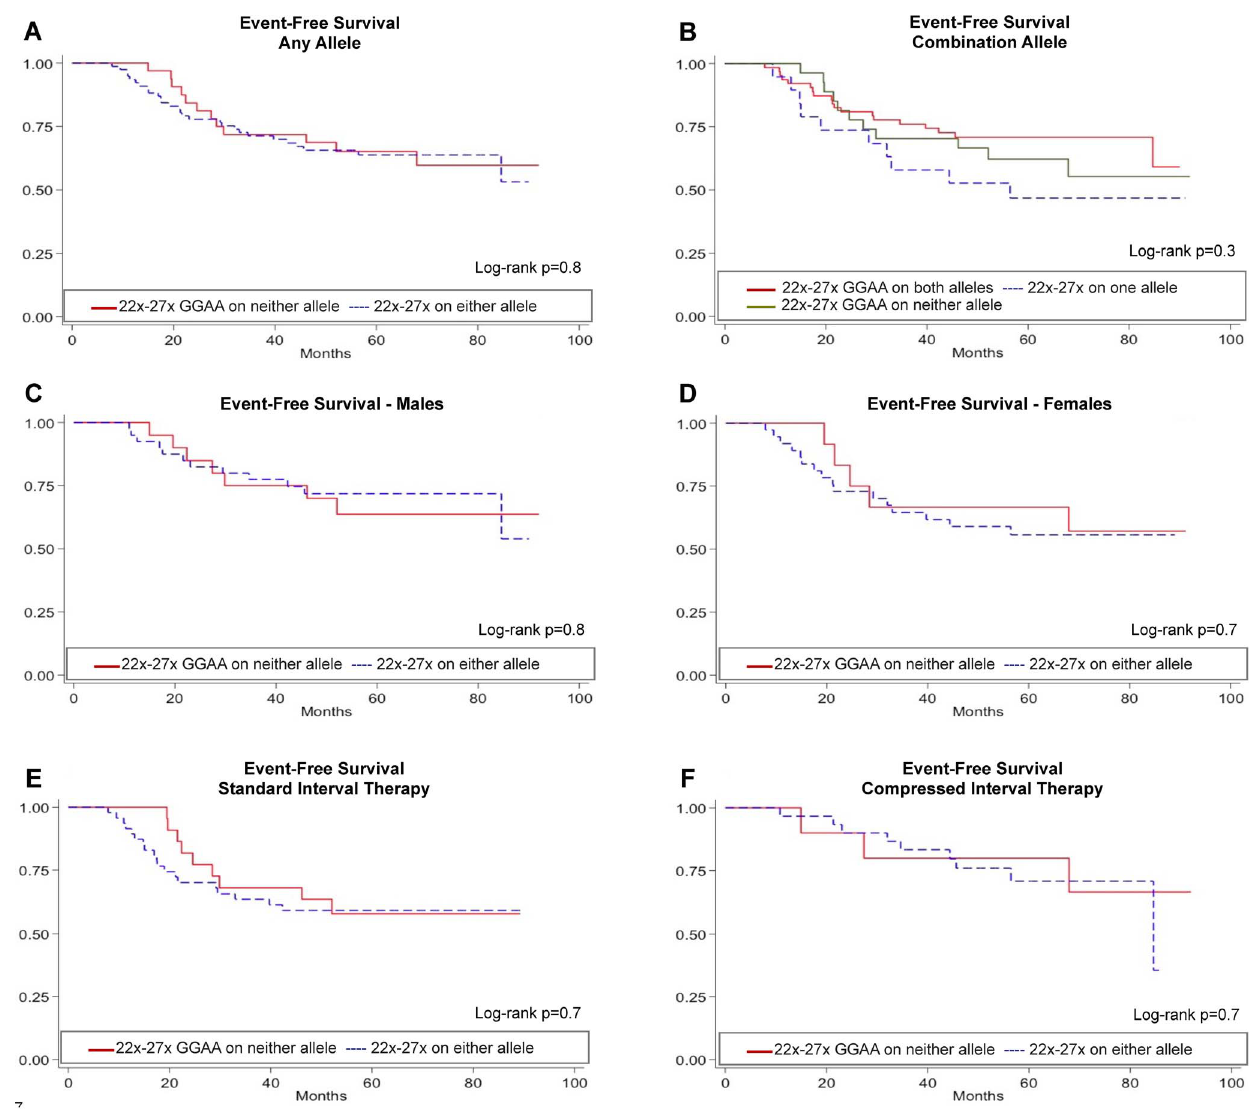
Figure 6. NR0B1 GGAA-microsatellite polymorphisms do not influence event free survival (EFS) in Ewing sarcoma patients. ( A ) EFS was compared in 112 patients from AEWS0031 based on the presence of absence of at least one NR0B1 GGAA-microsatellite allele containing 22–27 GGAA motifs. This allele type was chosen based on the pattern of alleles present in tumor samples and the maximal EWS/FLI-mediated gene expression supported by alleles of this length category. ( B ) EFS was similarly assessed based on the presence of one or both alleles containing 22–27 GGAA motifs. Additional subgroup analyses were also performed in males ( C ) and females ( D ) and in patients receiving standard ( E ) or compressed ( F )